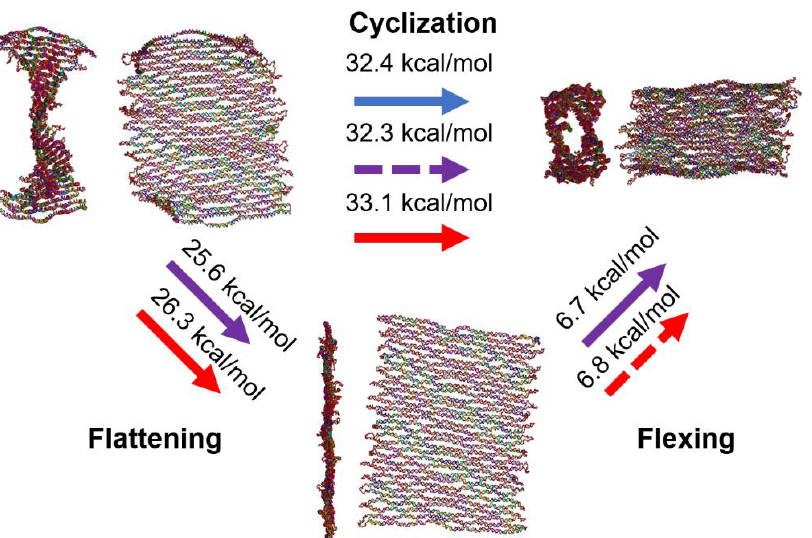
Figure 6. Overall analysis of the cyclization process. The cyclization of a DNA origami tile with a twist may be conceptualized as a two-step (flattening and flexing) process by introducing a hypothetical intermediate planar conformation. Blue, purple, and red arrows indicate the experiment, theory, and simulation, respectively. Solid arrows denote the direct results, while dashed arrows mark the indirect results from summation or subtraction of direct results. Experimentally determined free energy change for cyclization is approximately 32.4 kcal/mol. The theoretical value for the cyclization energy is obtained as ~32.3 kcal/mol by adding energies for flattening and flexing steps. The MD simulations yield a cyclization energy of about 33.1 kcal/mol, consistent with the experimental and theoretical values.